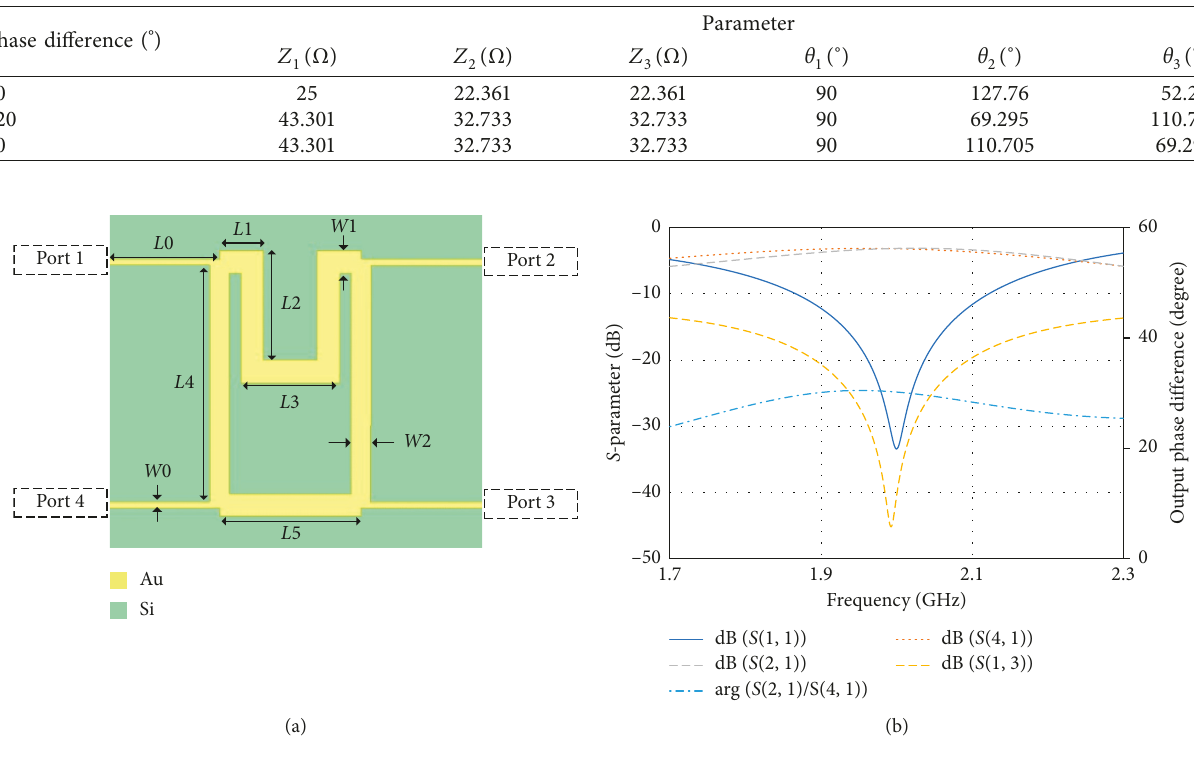
Table 2: Characteristic impedance and electrical length of the coupler.